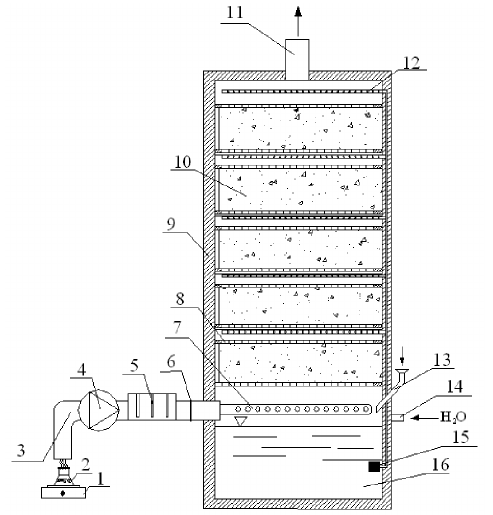
Fig. 1. Stand of biofilter: 1 – electrical stove, 2 – bulb